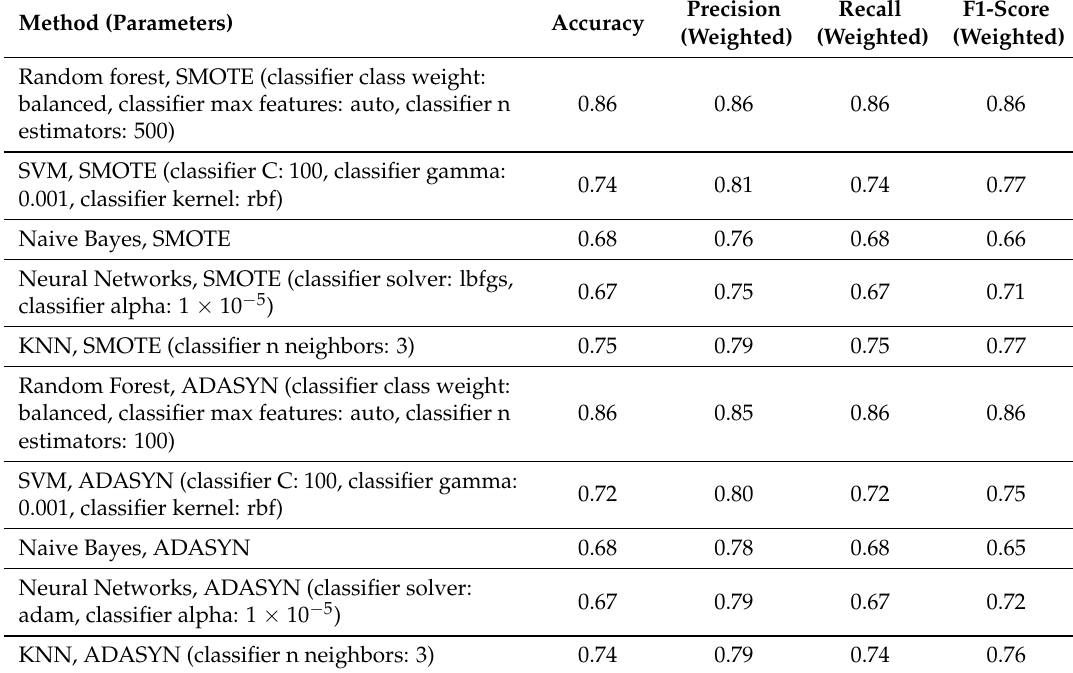
Table 2. Performance of the different methods in the coarse granularity. Synthetic minority over-sampling technique (SMOTE), support vector machine (SVM), k-nearest neighbors (KNN), adaptive synthetic